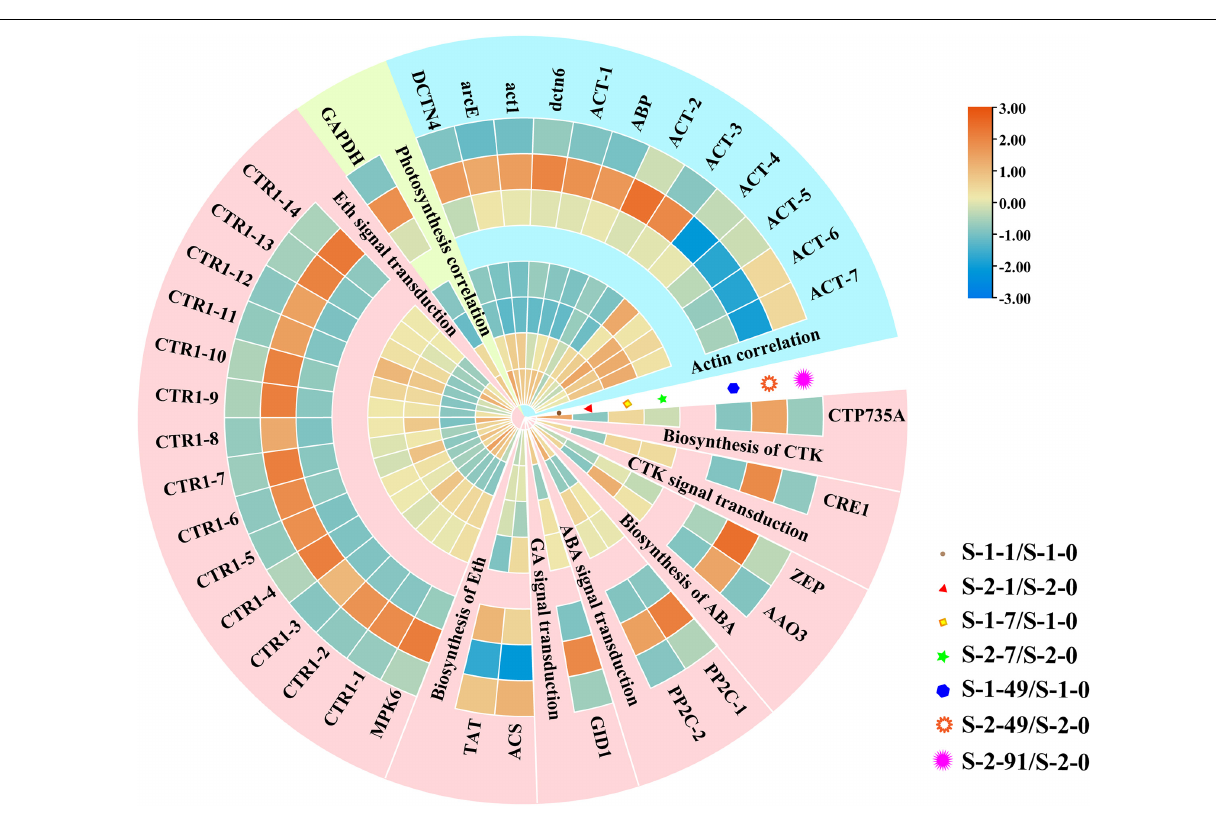
FIGURE 8 | Hierarchical clustering of downstream genes coordinated by PA. Red: up-regulation; Blue: down-regulation. Cerulean style indicates genes related to photosynthesis, pale yellow style indicates genes related to and actin rose red and style indicates genes related to plant hormone synthesis and signal transduction. Transcript levels of genes are shown as -fold changes in RPKM compared with that in S-1-0 or S-2-0. DCTN4, Dynactin p62; arcE, actin related protein 2/3; act1, actin type I; dctn6, Dynactin subunit 6; ACT, actin; ABP, actin binding protein; GAPDH, glyceraldehyde 3-phosphate dehydrogenase; CTP735A, cytokinin hydroxylase; CRE1, Sensory transduction histidine kinase; ZEP, Zeaxanthin epoxidase; AAO3, indole-3-acetaldehyde oxidase; PP2C, protein phosphatase 2C; GID1, hormone-sensitive lipase; ACS, 1-aminocyclopropane-1-carboxylate synthase; TAT, tyrosine aminotransferase; MPK6, Mitogen-activated protein kinase; CTR, constitutive triple response